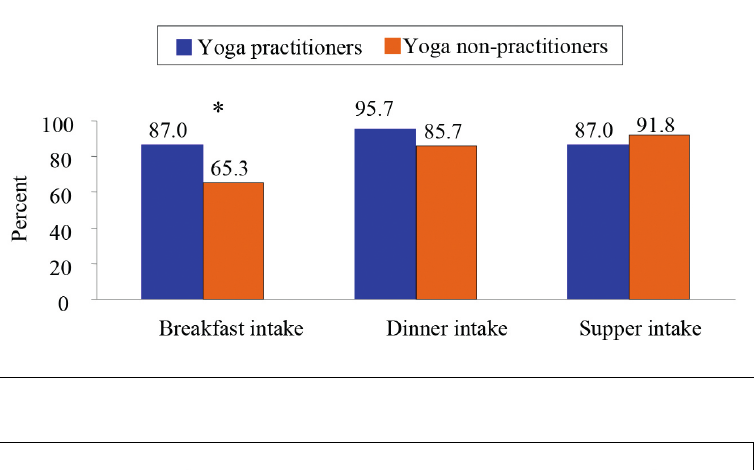
Figure 2. Pattern of food intake in women yoga practitioners and